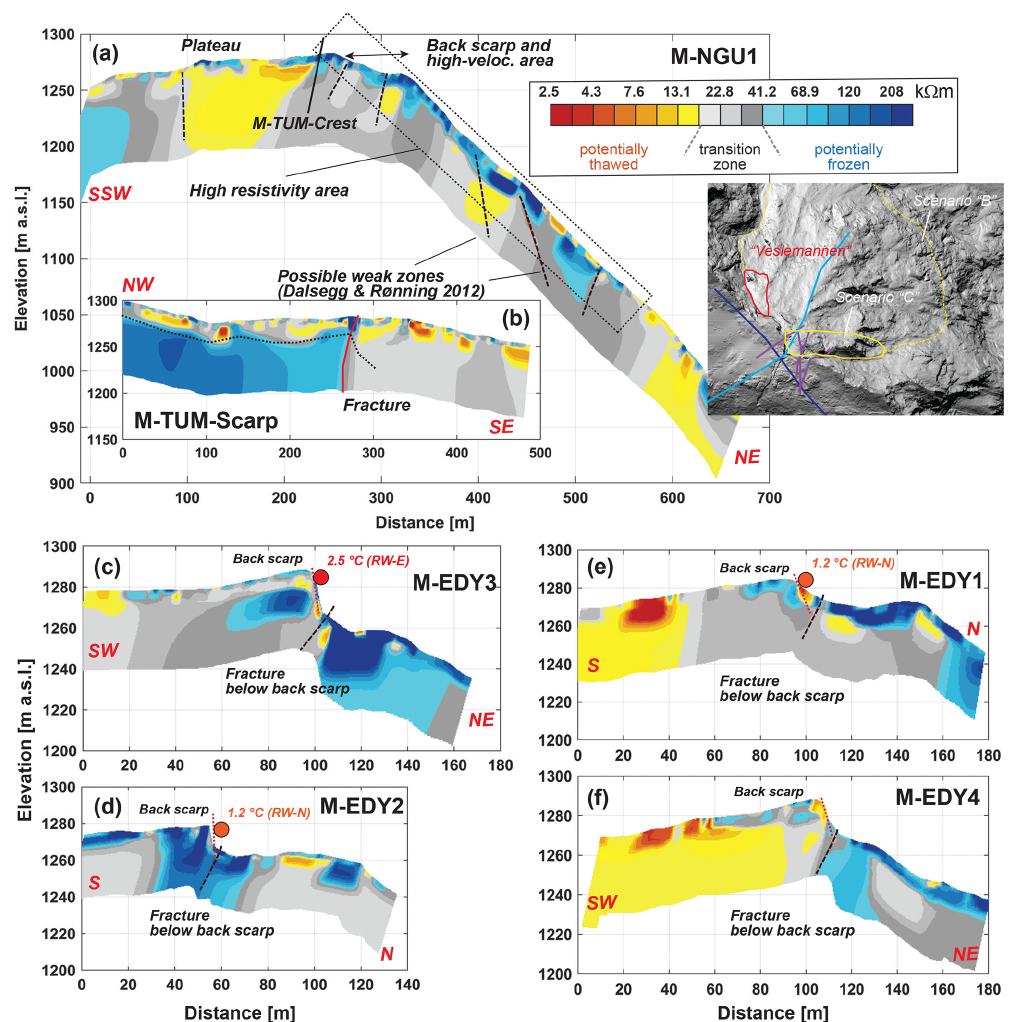
Figure 12. ERT surveys over the Mannen instability; for location see Fig. 1 and for survey parameters see Table 1. (a) Along-slope profile (M-NGU) based on Dalsegg and Rønning (2012). The possible weakness zones described in Dalsegg and Rønning (2012) are indicated by dashed lines. The near-surface high-resistivity area is indicated by a box; it may reveal crushed air-filled and well-drained bedrock and may contain permafrost patches (Dalsegg and Rønning, 2012). (b) M-TUM-scarp profile along the rim on the plateau of Mannen above the exposed slip surface. A strong transition of resistivity is indicated by a red line and interpreted as a deep fracture that may be water-filled. Panels (c) to (f) show the ERT profiles (M-EDY1-4) over the rock wall from the plateau into the instability at various locations (Fig. 1). The circles show the mean annual rock wall temperatures in the two loggers on site. The exposed back fracture below the slip surface is indicated by dashed lines, while the back scarp is indicated by a red dotted